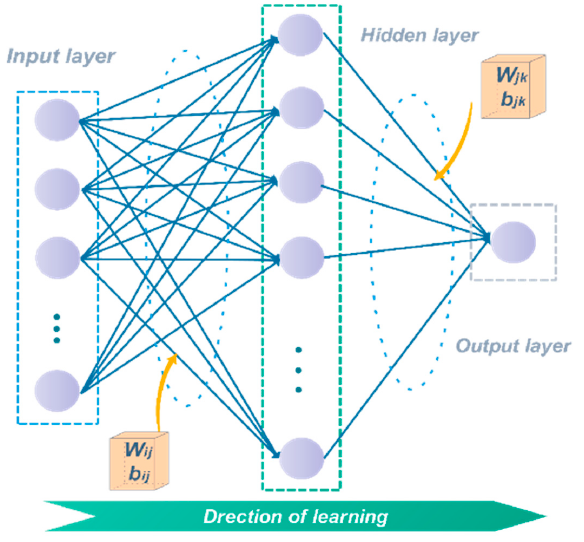
Figure 1. The three ‐ layer BP neural network structure. Figure 1. The three-layer BP neural network